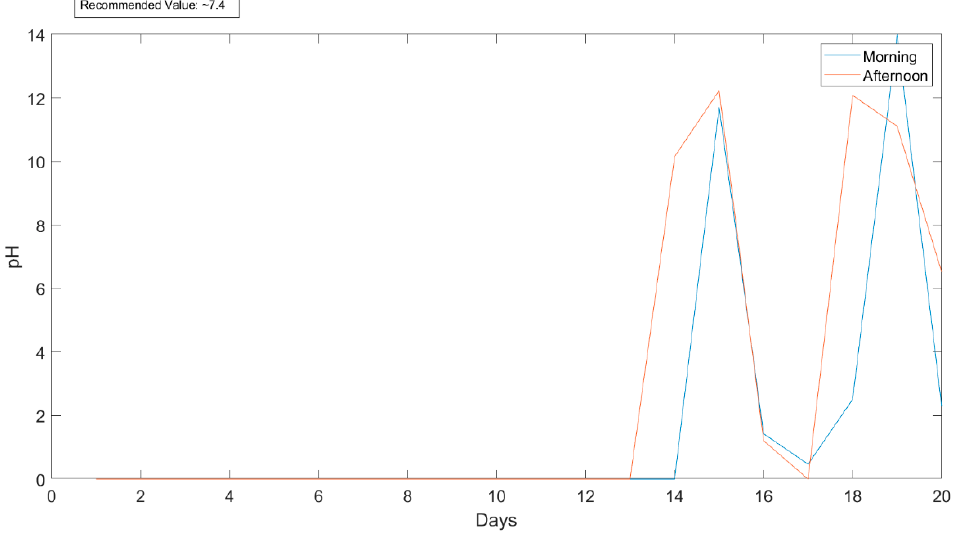
Figure 11. Total dissolved solids (TDS) Variation.